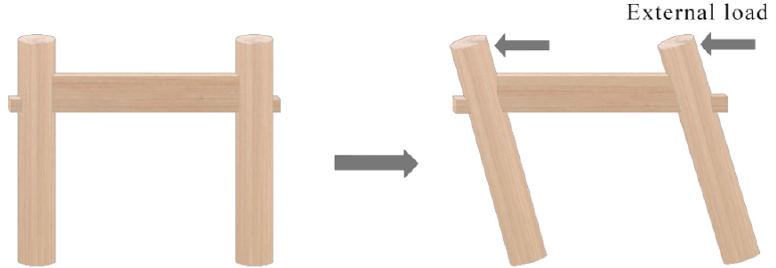
Figure 8. Rotation of timber frame under external load.